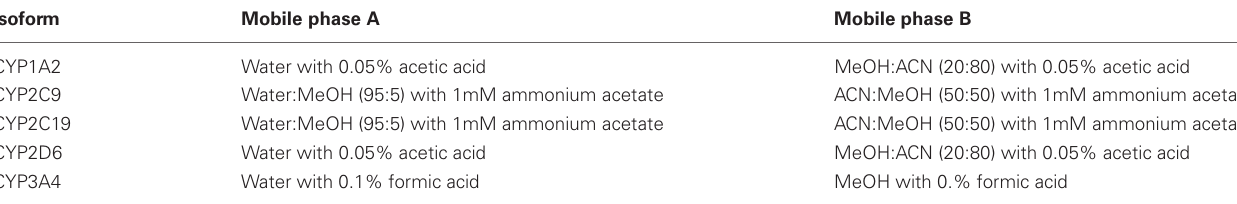
Table A3 | Mobile phase composition.